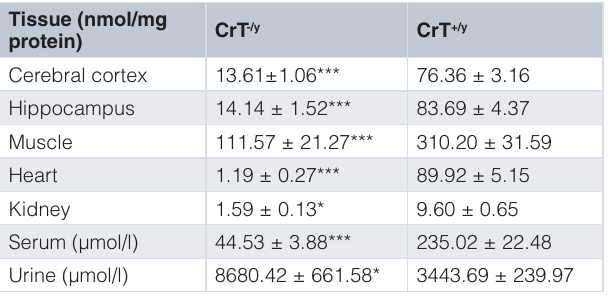
Table 1. Depletion of Cr levels in CrT –/y mutant mice. Cr levels (mean ± SEM) in CrT –/y and CrT +/y animals (n = 4 per tissue for both groups, except n = 5 for urine measurement in CrT −/y mice). Cr levels have been measured by GC/MS. A reduction of Cr content was evident in the brain, muscle, heart, kidney and serum of mutant animals, while an increase of Cr levels was reported in urine (Two Way ANOVA on rank transformed data, post hoc Holm-Sidak method). * p < 0.05; *** p < 0.001.